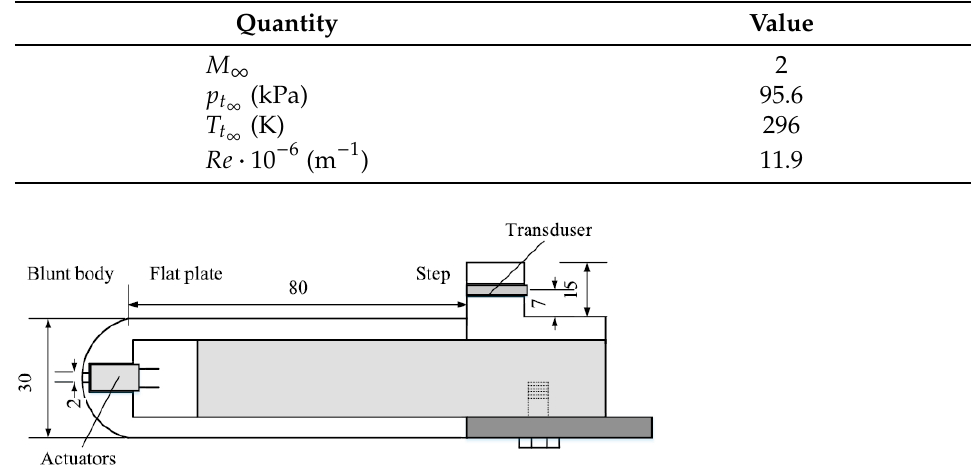
Figure 2. Model (side view). Reprint from [48] with permission from